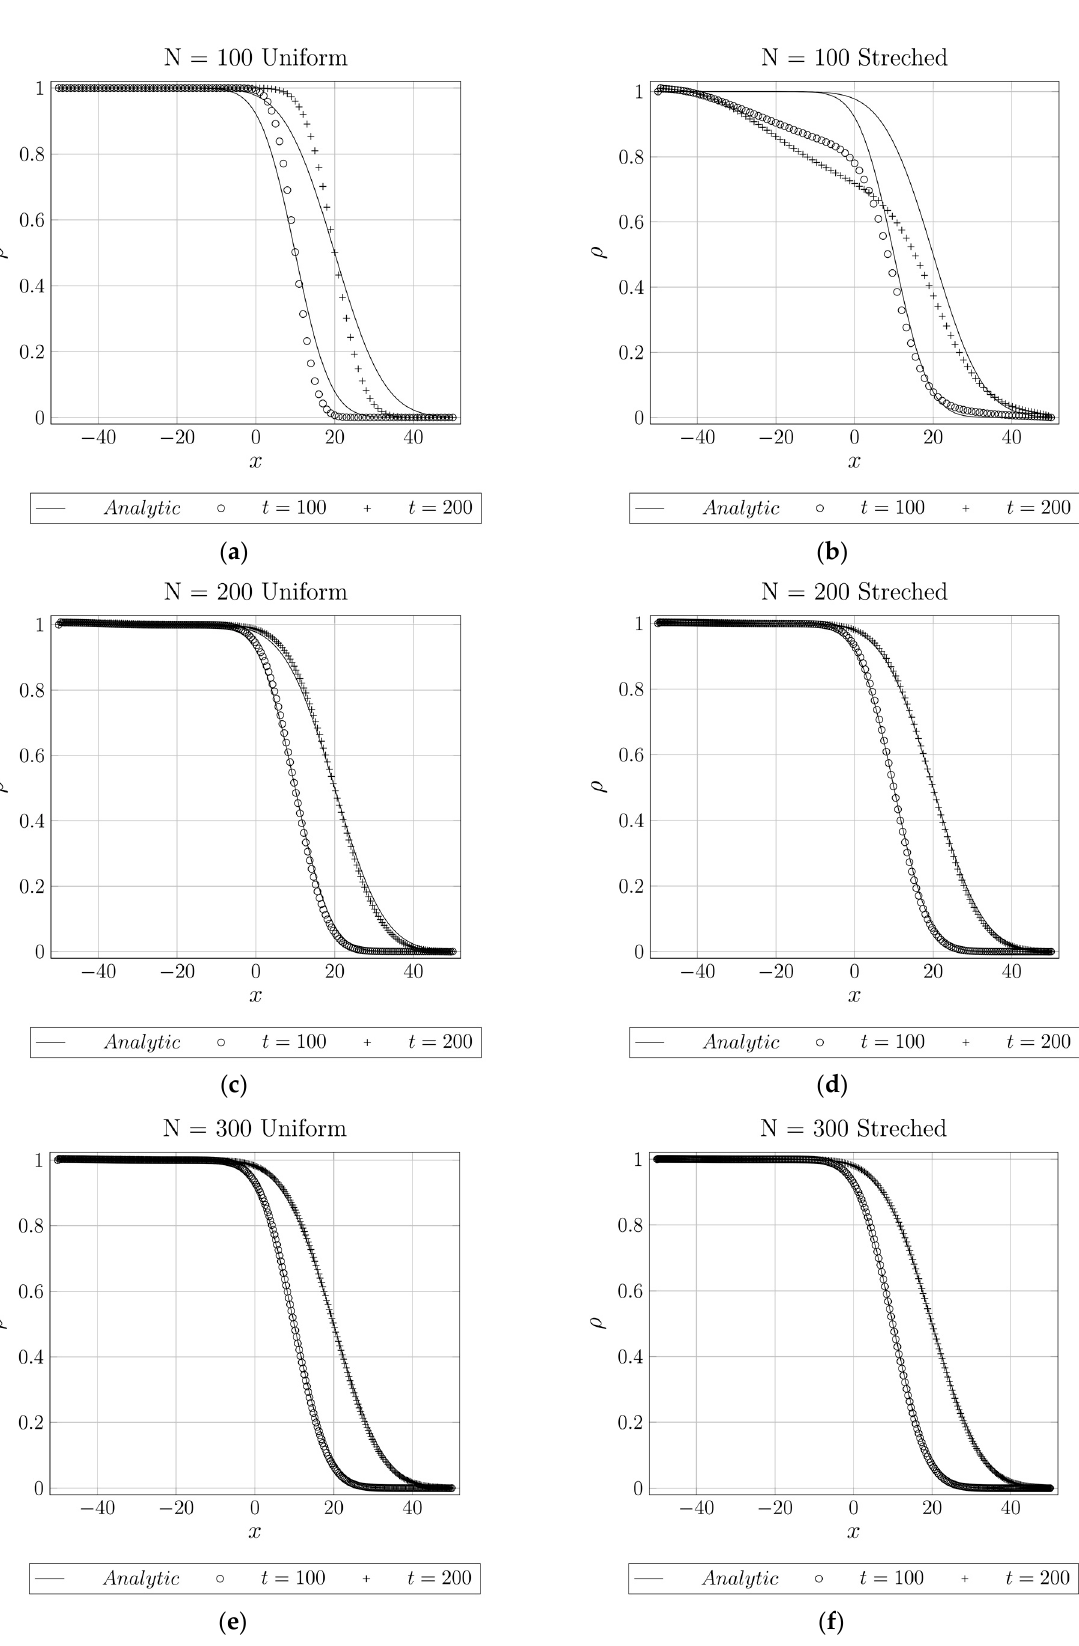
Figure 4. Advection–diffusion problem solved by LBM with regular streaming for 100 uniformly distributed points.